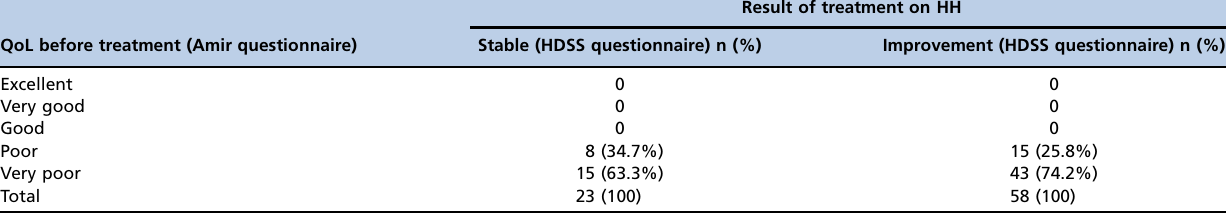
Result of treatment on HH